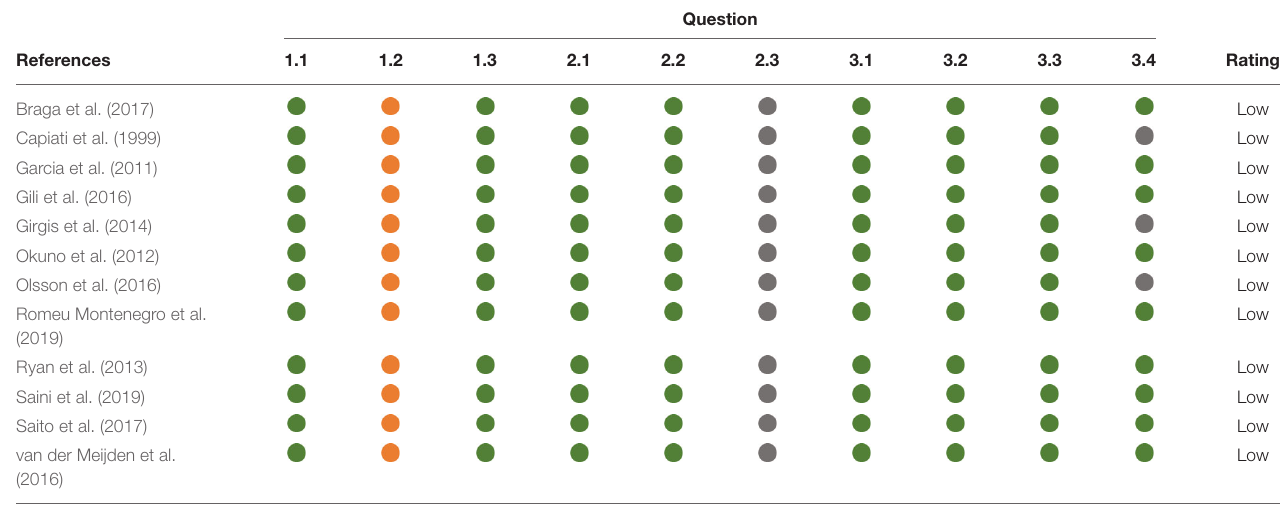
TABLE 1 | Summary of quality assessment of included studies.